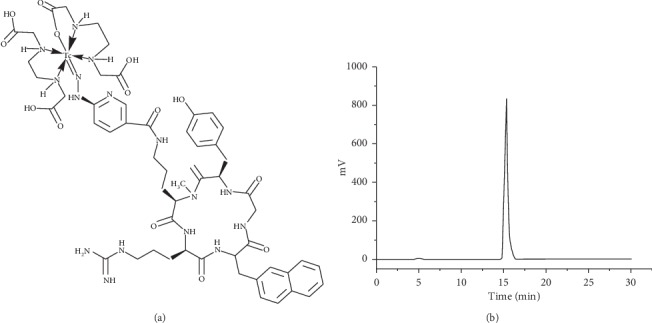
(a) Schematic structure of 99mTc-CXCR4-L. (b) Reversed-phase radio-HPLC analysis of 99mTc-CXCR4-L obtained from the freeze-dried kit before injection to patients with radiochemical purity >97%.